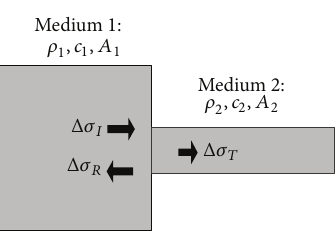
Figure 3: The wave reflection and transmission at the